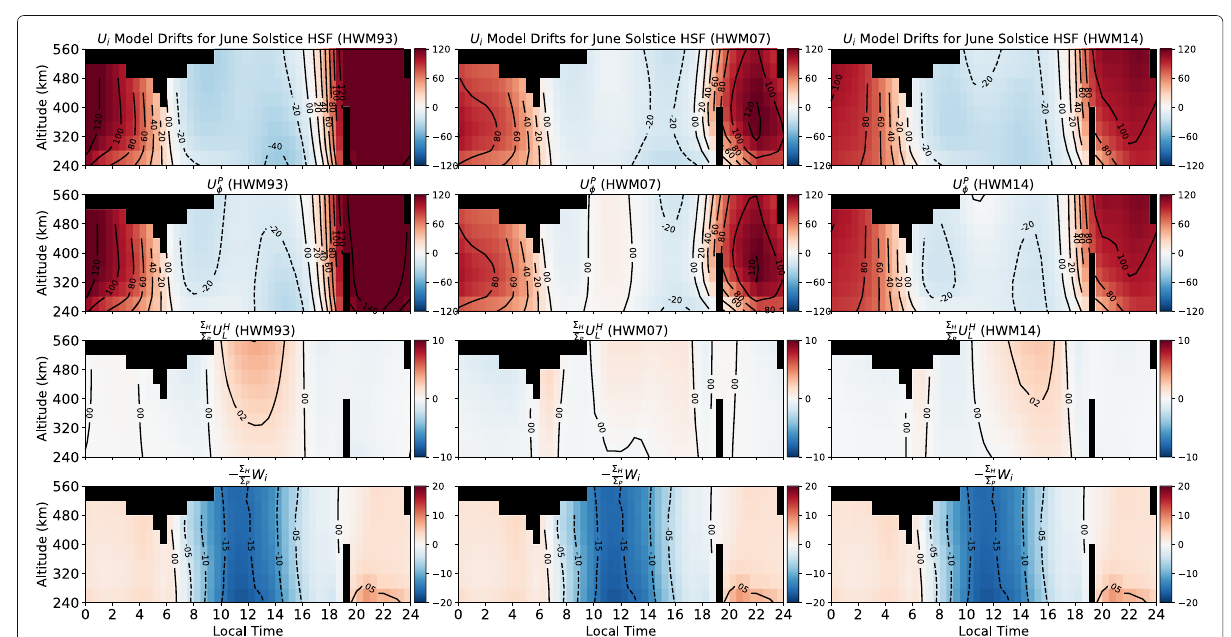
Fig. 6 The contribution of each term of Eq. 6 to the modeled zonal drifts. June solstice high solar flux (HSF)